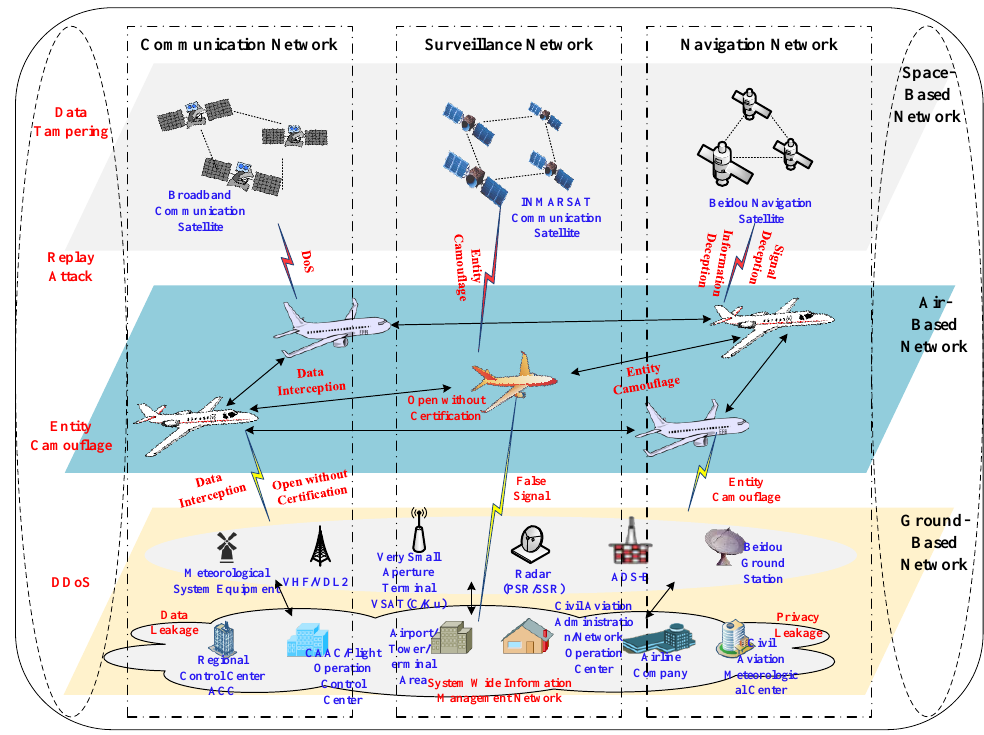
Figure 6. Networked ATM-CPS threat model.